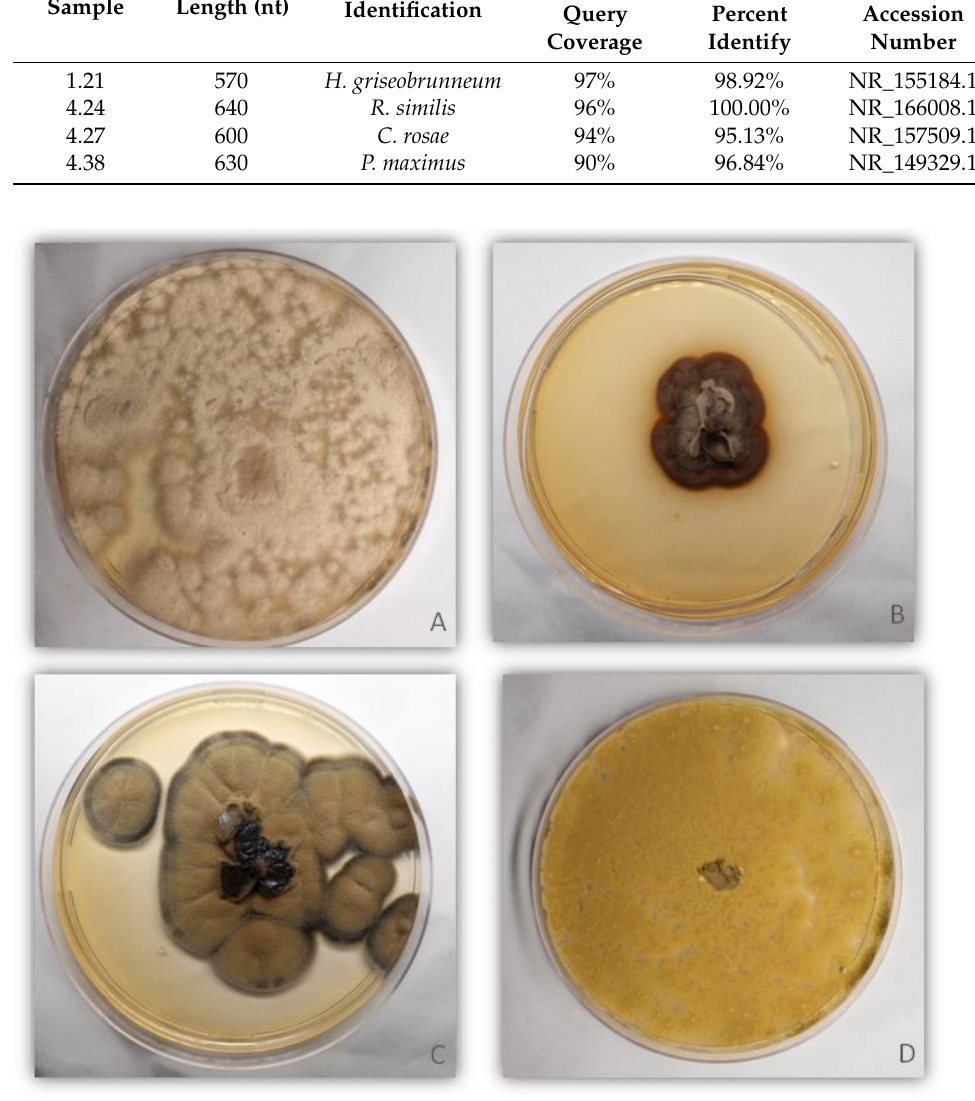
Figure 2. Morphological characteristics of the isolates identified at the species level: ( A ) H. griseobrunneum , ( B ) R. similis , ( C ) C.rosae , and ( D ) P. maximus .